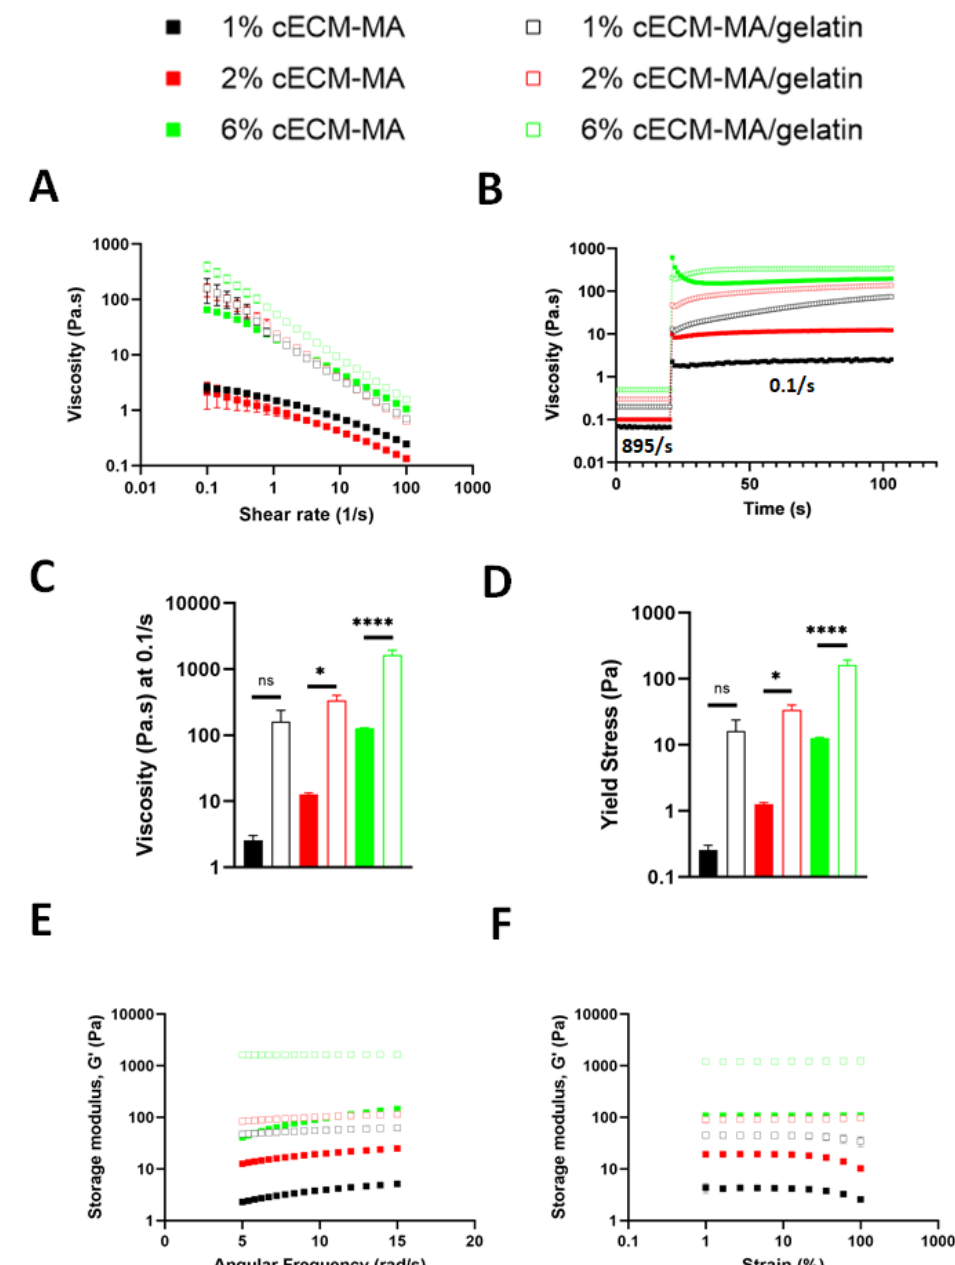
Figure 3. Rheological properties of formulations containing methacrylated cartilage ECM, with and without gelatin ( n = 3). ( A ) Shear rate sweep from 0.1 to 100/s. ( B ) Shear recovery from 895/s (first 20 s) to 0.1/s (last 100 s). ( C ) Effect of inclusion of 3.5% gelatin on the viscosity of 1, 2, and 6% cECM-MA formulations at a shear rate of 0.1/s (close to zero shear) (ns = not significant; * = p < 0.05; **** = p < 0.0001). ( D ) Effect of the inclusion of gelatin on the yield stress (taken at 0.1/s) of 1, 2, and 6% cECM-MA formulations (ns = not significant; * = p < 0.05; **** = p < 0.0001). ( E ) Frequency sweeps of 1, 2, and 6% cECM formulation (only G’ shown for clarity). ( F ) Amplitude sweeps of 1, 2, and 6% cECM formulations (only G’ shown for clarity). Table 1. Quantitative description of bioink rheological properties.